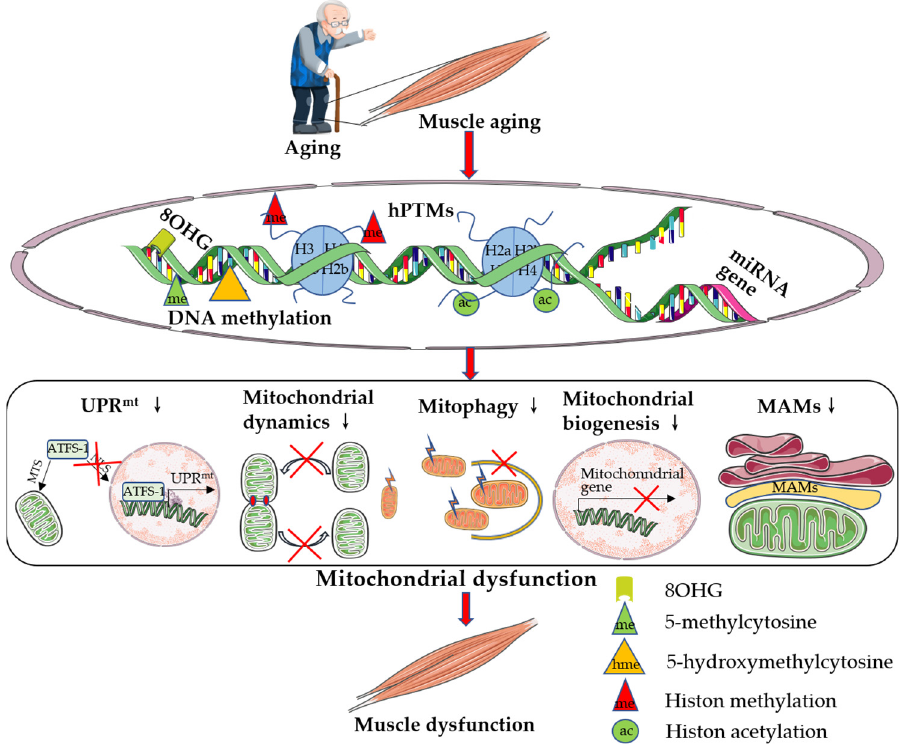
Figure 1. Aging induces skeletal muscle mitochondrial dysfunction via epigenetic modifications. Skeletal muscle aging affects nuclear genomic DNA methylation, hPTMs, and miRNA expression, which subsequently inhibit mitochondrial quality control, leading to mitochondrial and skeletal muscle dysfunction. For abbreviations, see the list at the end of the